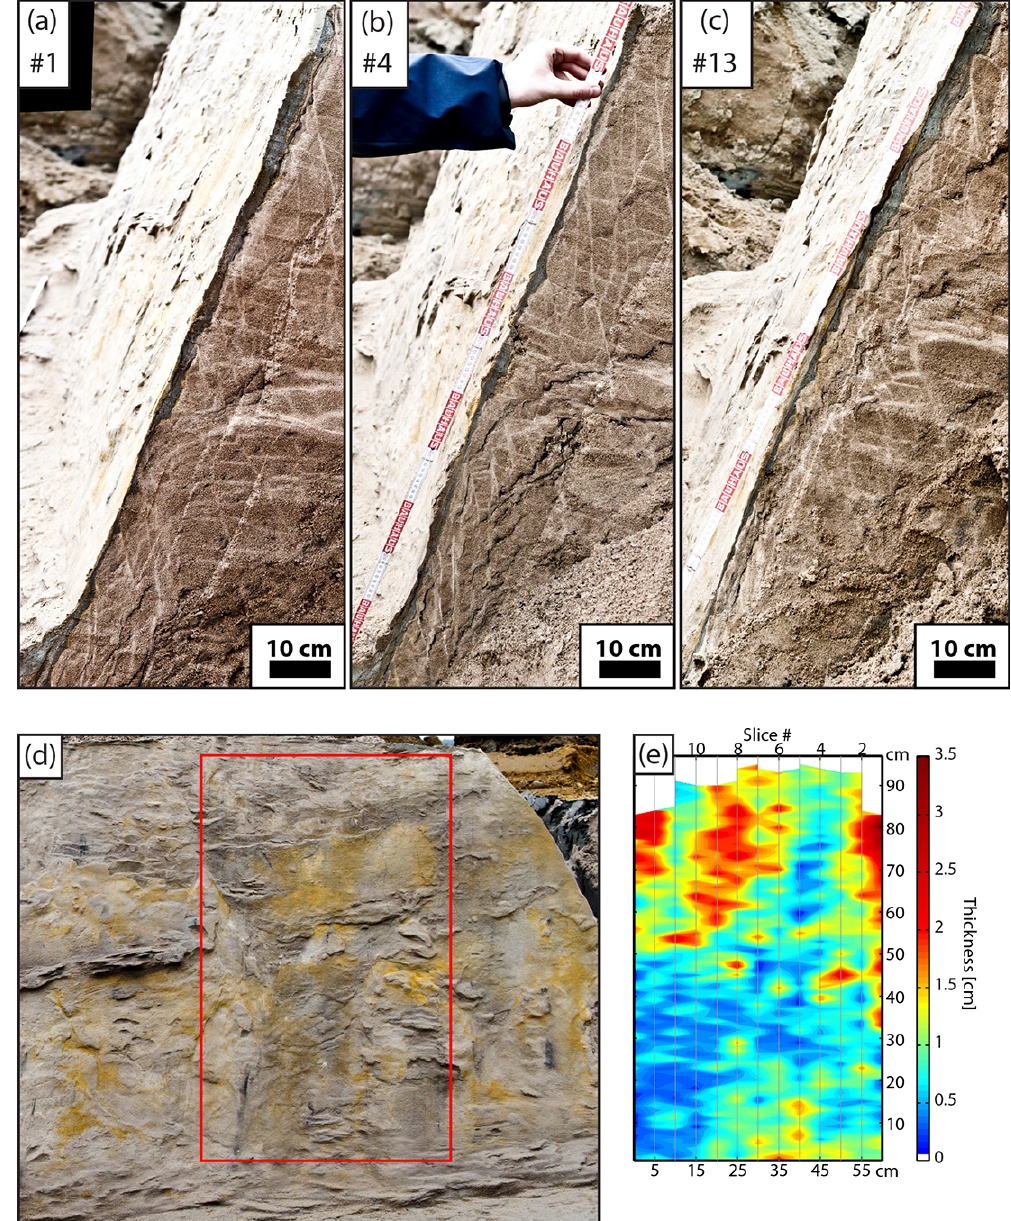
Figure 9. A thickness map of a section of surface 2 compiled from 13 vertical profiles ( a–c ). Location of the thickness map in (d) . Colour- coded thickness map (e) . Thickness varies vertically and laterally. A trend towards thinner clay smears appears at the lower left.